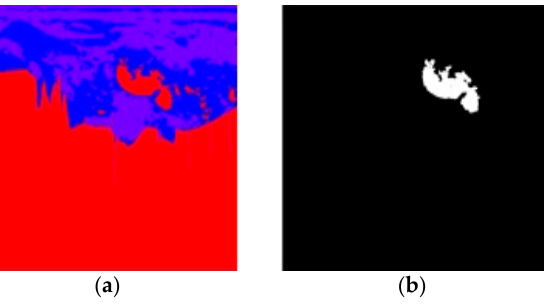
Figure 7. Effect of 8-directional search. ( a ) Quantized result, ( b ) candidate cyst. Connected component labeling [29] is a simple and efficient algorithm. It is applied similar color and are adjacent to each other. Every connected component in the image is labeled